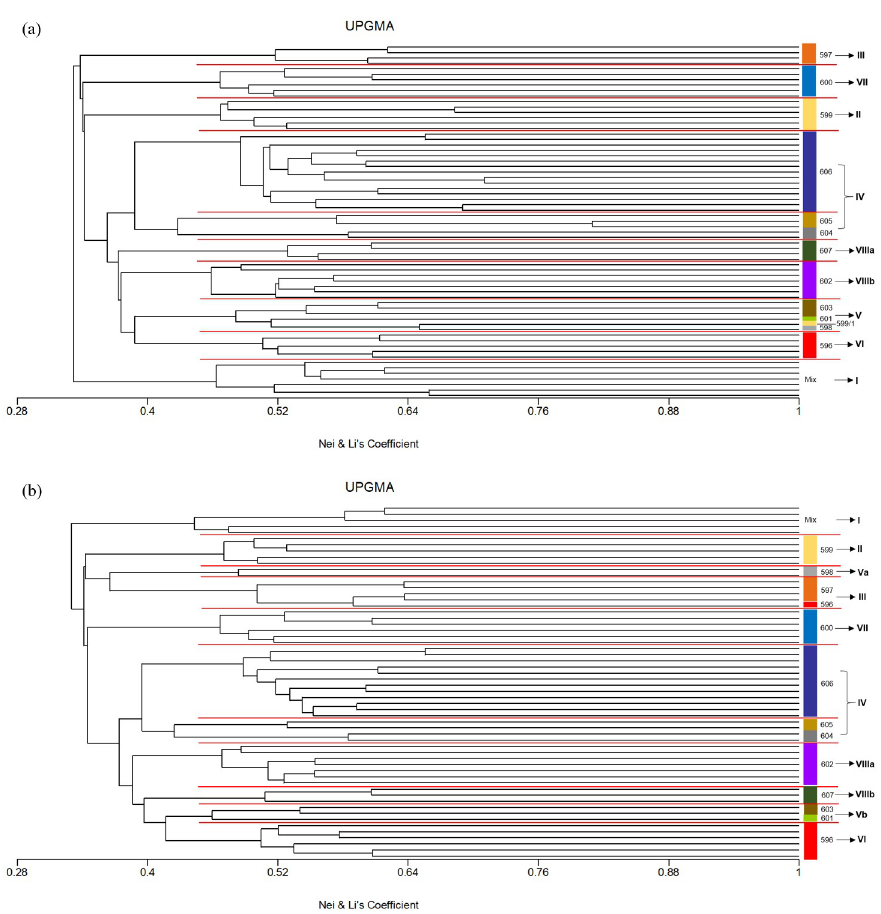
Fig 5. UPGMA clustering of the core collections based on Nei and Li’s coefficient. (a) Core collection developed using PowerCore; (b) Core collection developed using Core Hunter.